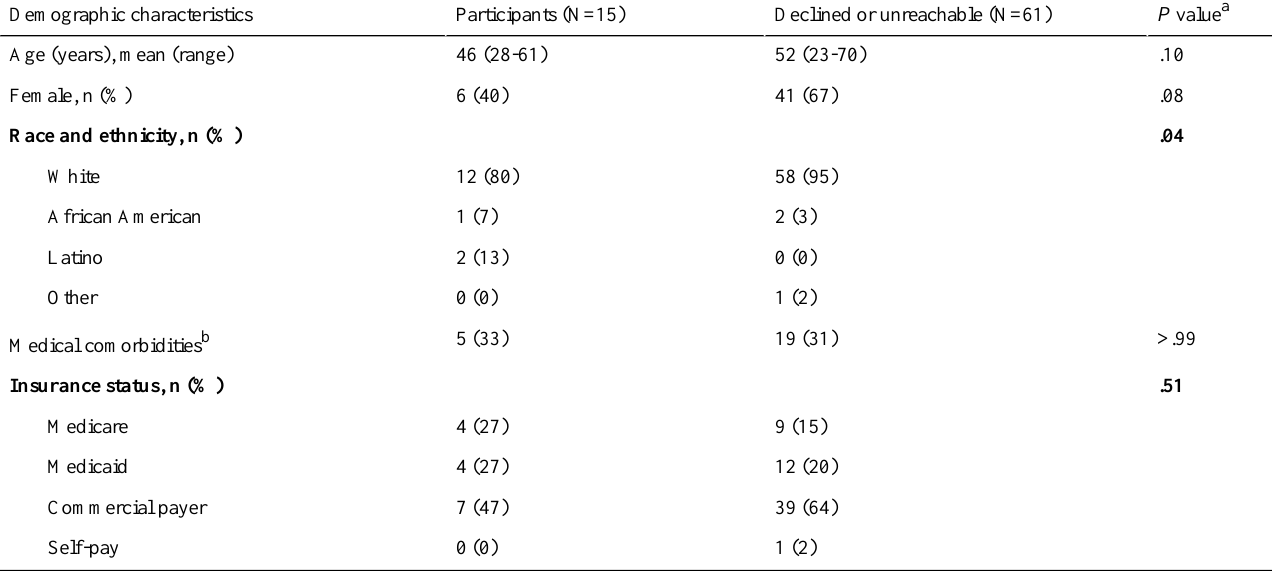
Table 1. Characteristics of